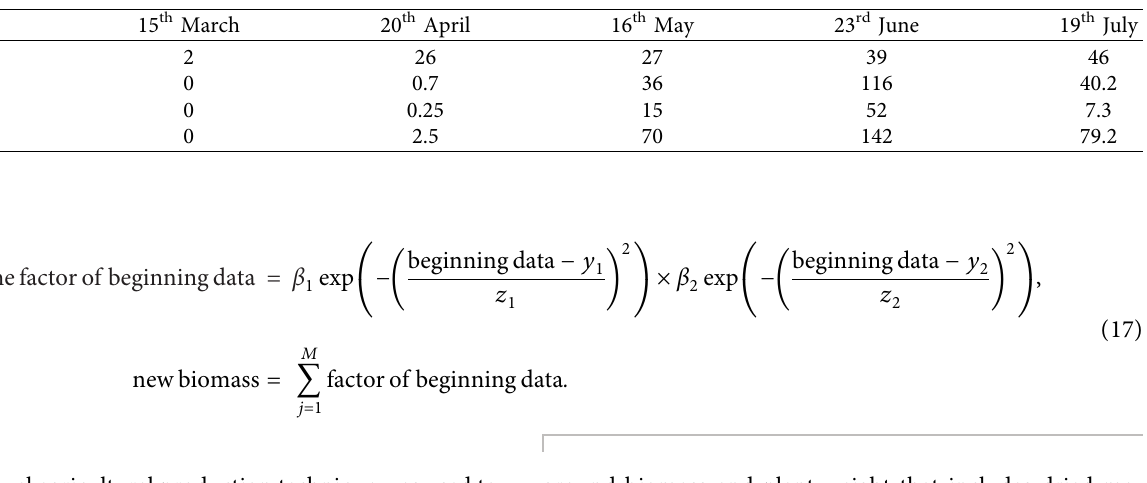
Figure 6: Crops in Bekaa Valley. Table 4: Estimated biomass production for potato in